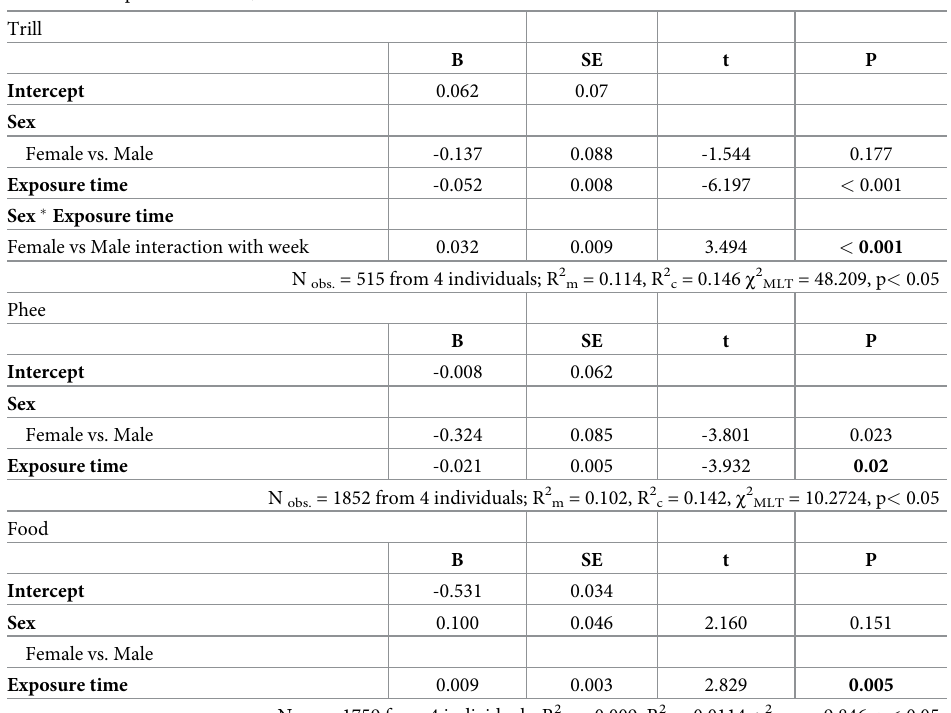
Table 3. Social accommodation over time. The effect of sex, exposure time and the interaction thereof on vocal dis- tance (ln-transformed Euclidean distance) between the vocalisations of four translocated MA individuals and the call type specific average of the new population (“Baseline ZH colony”) for each call type. Parameter estimates, standard errors, and statistical significance are obtained from a linear mixed effects model. Significant (highest-order) effects are indicated with p-values in bold, trends in